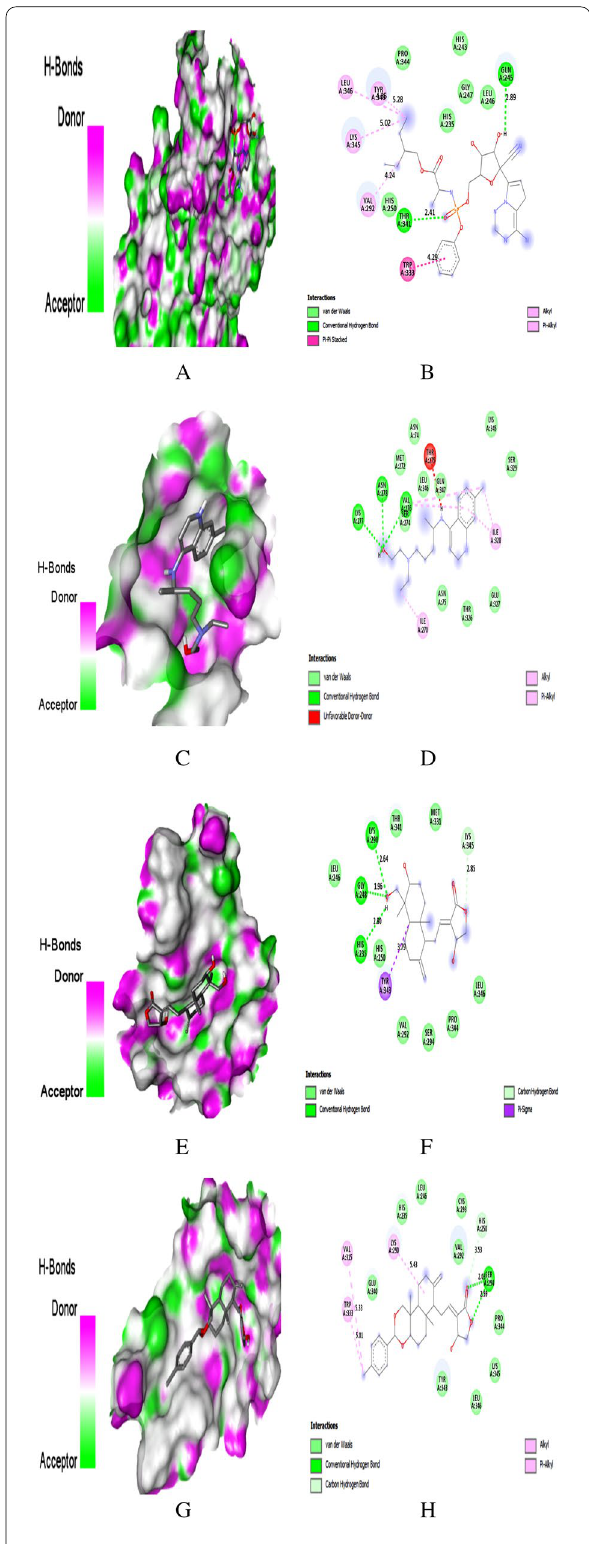
Fig. 6 Docking with NSP15. A Docking pose of REM on hydrogen bonding surface. B 2D interaction of REM. C Docking pose of HCQ on hydrogen bonding surface. D 2D interaction of HCQ. E Docking pose of AGP on hydrogen bonding surface. F 2D interaction of AGP. G Docking pose of AGP-15 on hydrogen bonding surface. H 2D interaction of